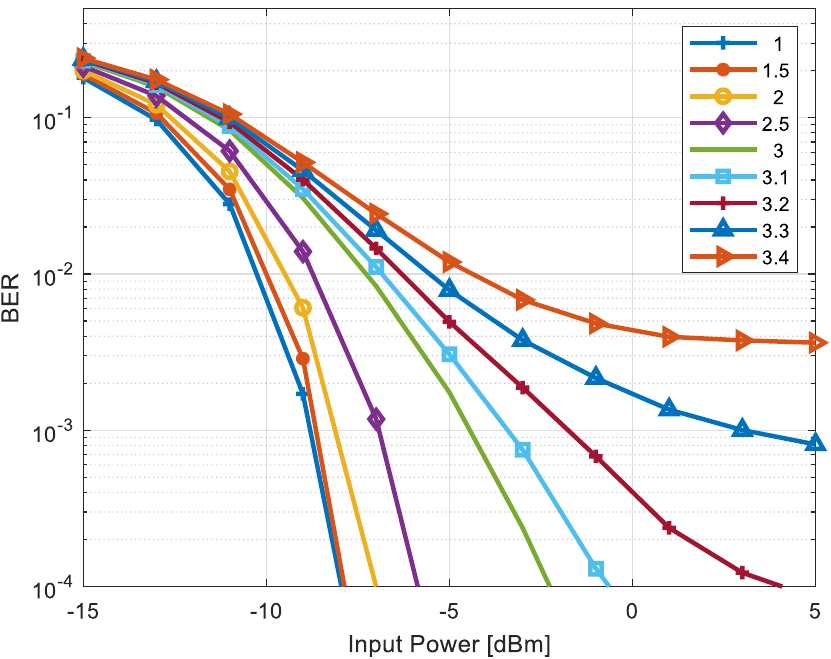
Figure 10. Bit error rate (BER) curves vs. optical input power for different fiber lengths (km) using a 2nd order SG filter with 3 dB BW at 40 GHz.